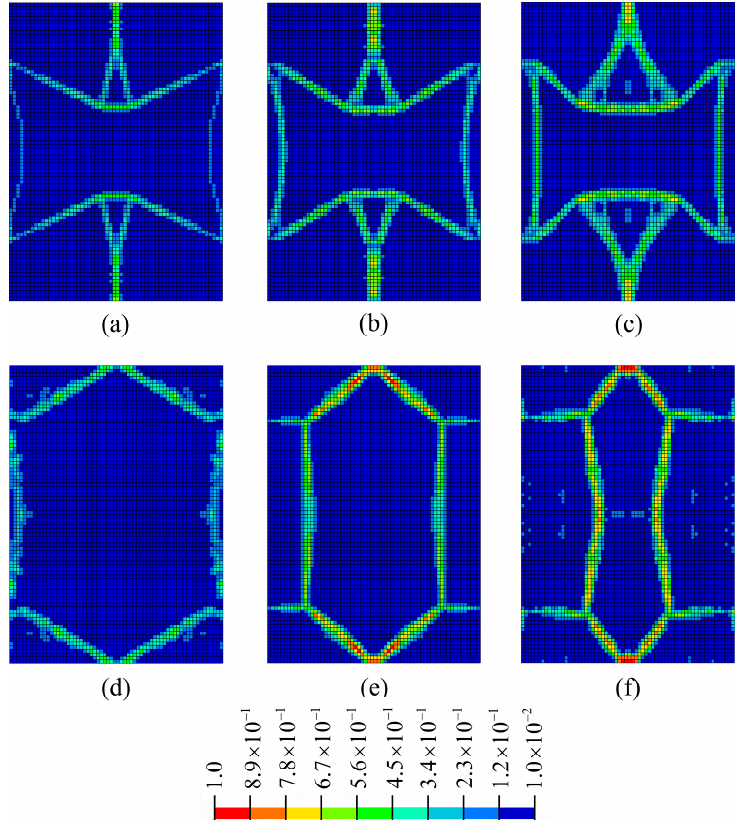
Figure 3. Optimal configurations of functional element corresponding to various Poisson’s ratio (PR) values: ( a ) 𝜈 = −0.3 ; ( b ) 𝜈 = −0.6 ; ( c ) 𝜈 = −1.0 ; ( d ) 𝜈 = +0.3 ; ( e ) 𝜈 = +0.6 ; ( f ) 𝜈 = +1.0 .